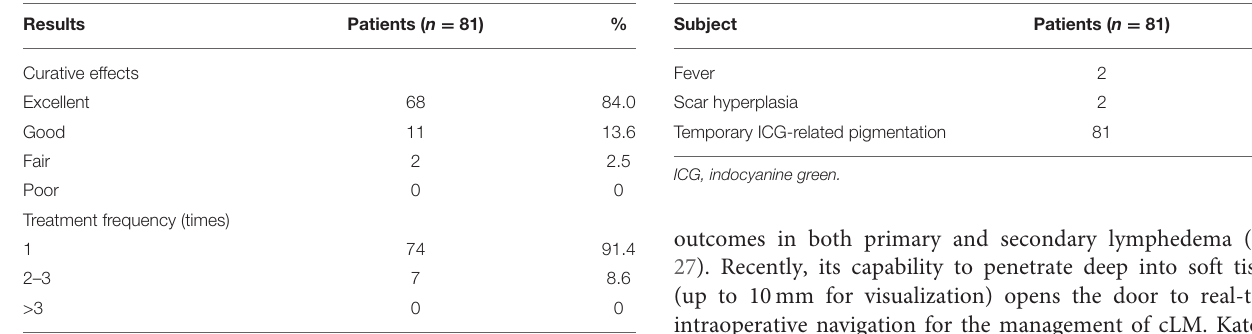
TABLE 2 | Outcomes of the postoperative period. TABLE 3 | Postoperative